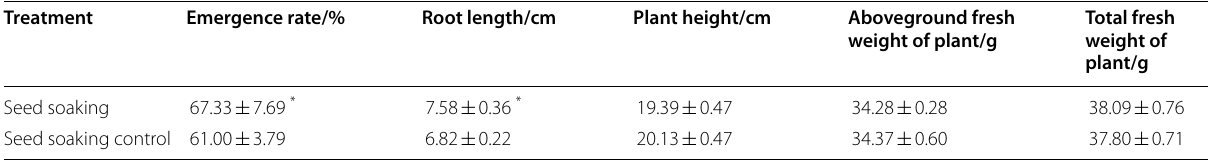
Table 5 Effect of EBS03 on seedling biomass indexes of cotton Treatment